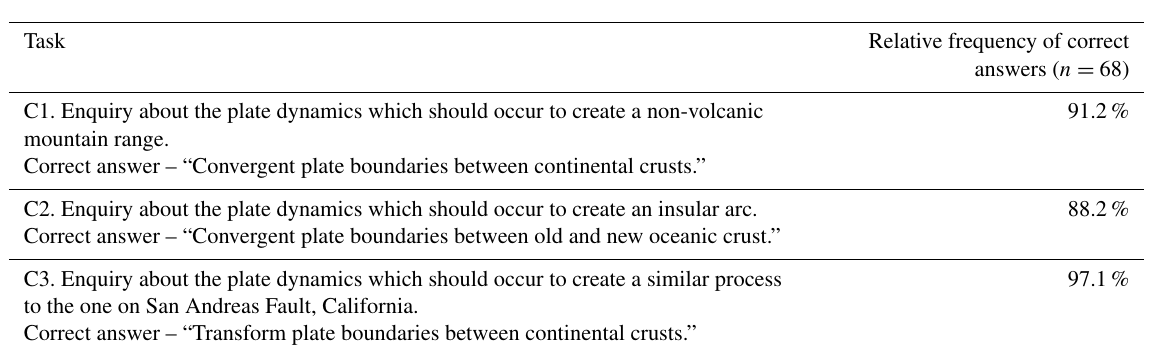
Table 4. Pre-service teachers’ enquiry results for C1 to C3 .